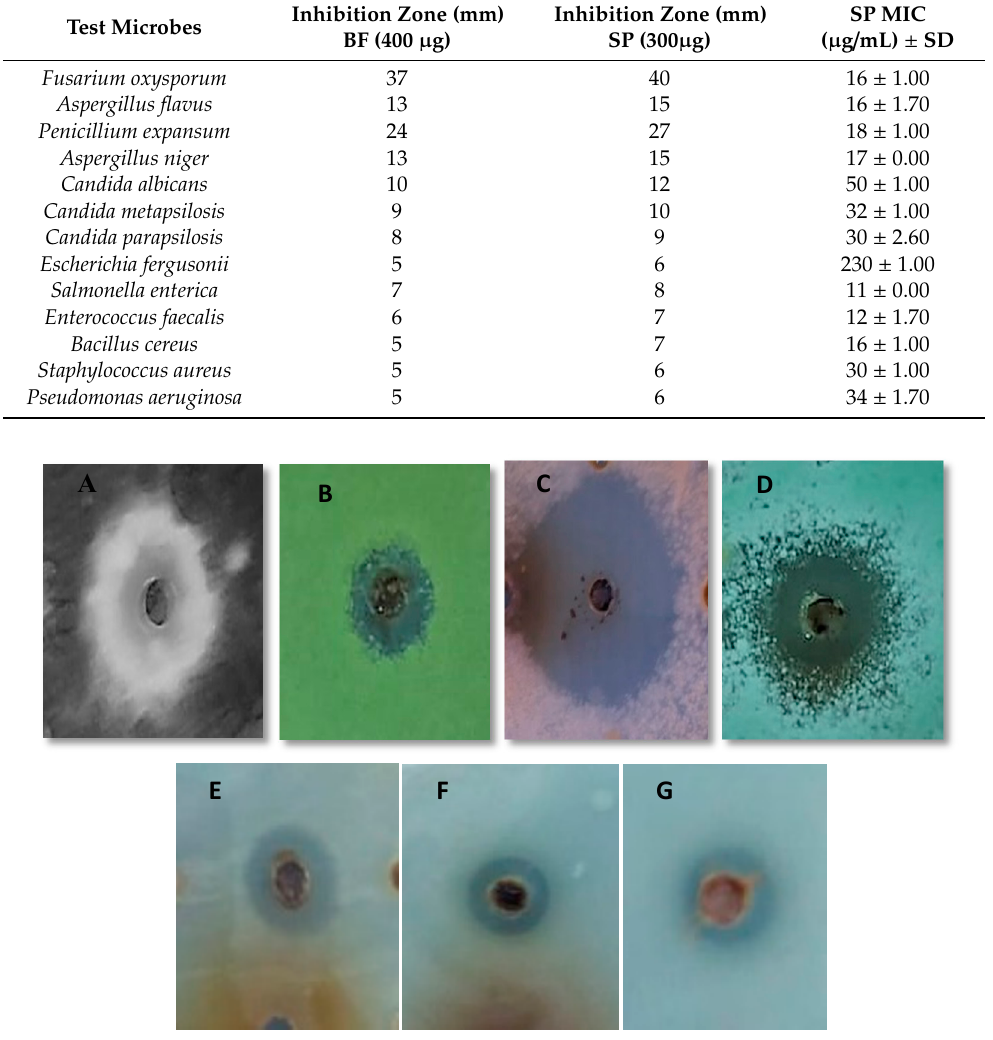
Table 2. Inhibition zone of the biological fraction (BF) and the synthetic peptide (SP), and the minimal inhibitory concentration (MIC) of (SP) on the tested microbes.